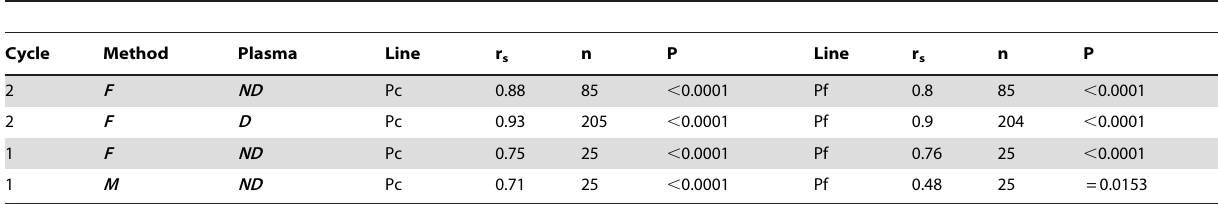
Figure 2. PfMSP1-19 inhibition by Mugil plasma under various experimental conditions. ( A ) Level of PfMSP1-19 specific inhibition measured by flow cytometry for non-dialysed Mugil plasma ( 6 , n=192, 2 cycle), dialysed Mugil plasma ( + , n=205, 2 cycle), ammonium sulfate precipitated PNG plasma at a 1 in 10 dilution ( ¤ , n=6, 2 cycle), ammonium sulfate precipitated PNG plasma at a 1 in 5 dilution ( w , n=6, 2 cycle), non- dialysed Mugil plasma ( m , n=33, 1 cycle) and non-dialysed Mugil plasma measured by microscopy ( N , n=25, 1 cycle). Central bar (green) represents the median MSP1-19 specific inhibition for the plasma samples. Boxes (blue) represent 2 standard deviations of the mean MSP1-19 specific inhibition of Melbourne control samples as a measure of assay variability. Bars (red) represent the maximum and minimum values of MSP1-19 specific inhibition for Melbourne controls. PfMSP1-19 specific inhibition was defined as the growth of PcMSP1-19 line minus growth of PfMSP1-19 line, expressed as a percentage of non-inhibitory controls. Samples were tested in duplicate and correlations between duplicate experiments are outlined in Table 1. Median growth of the PcMSP1-19 line and PfMSP1-19 line in the presence of ( B ) non-dialysed Mugil plasma (n=192) and ( C ) dialysed Mugil plasma (n=205) in 2 cycle flow cytometry based assays. Error bars represent inter-quartile range with dots representing samples with inhibition that falls outside this range. Horizontal bar and box represent median and IQR, whiskers represent the 5 th and 95 th percentiles. doi:10.1371/journal.pone.0027705.g002 A subset of samples (n= 20) with high levels of MSP1-19 immunoglobulin and removal of non-specific inhibitors (Fig. 2A). antibodies by ELISA were pooled and IgG was purified using Plasma from 5 PNG adults with high levels of PfMSP1-19 IgG by ammonium sulfate precipitation, allowing concentration of ELISA were treated by ammonium sulfate precipitation to purify Table 1. Reproducibility of parasite growth measurements between repeat